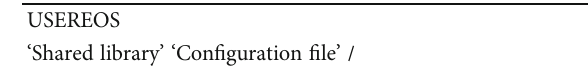
Table 5: The USEREOS keyword syntax. It takes two arguments: the paths to the library and con fi guration fi les.